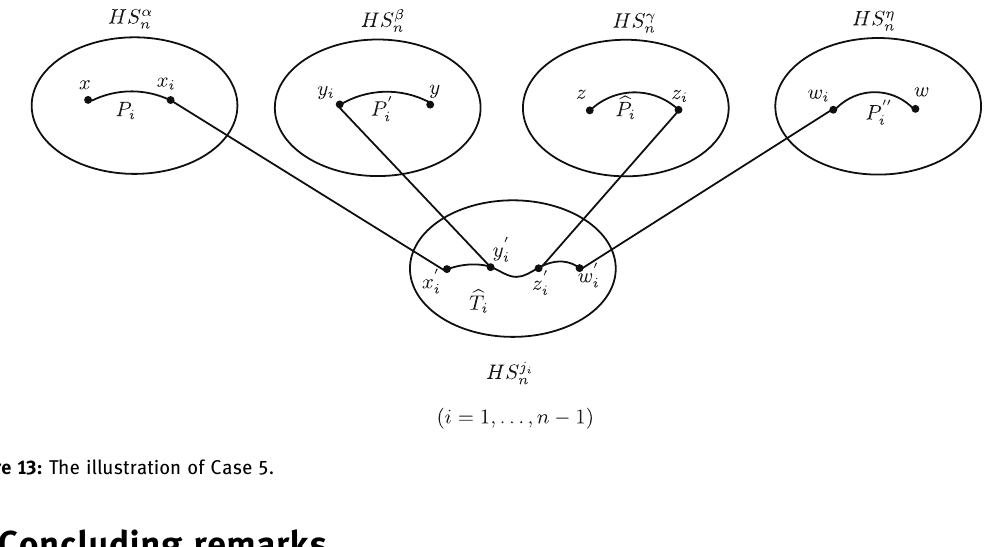
Figure 13: The illustration of Case